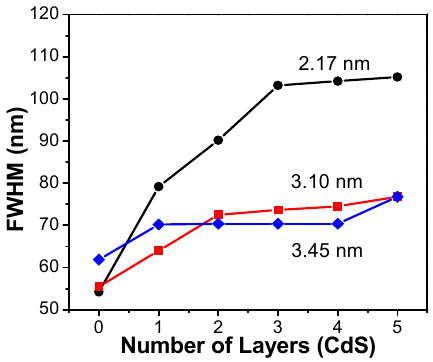
Figure 5. Full width at half maximum (FWHM) values for CdTe/CdS QDs prepared with CdTe nanocrystals of 2.17 nm, 3.10 nm, and 3.45 nm.